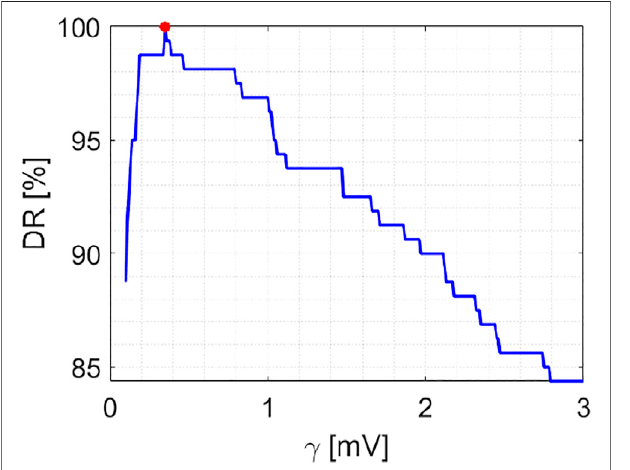
FIGURE 11 | Calibration step. DR versus threshold ψ for DSEM. The optimal threshold ψ p corresponds to the asterisk.